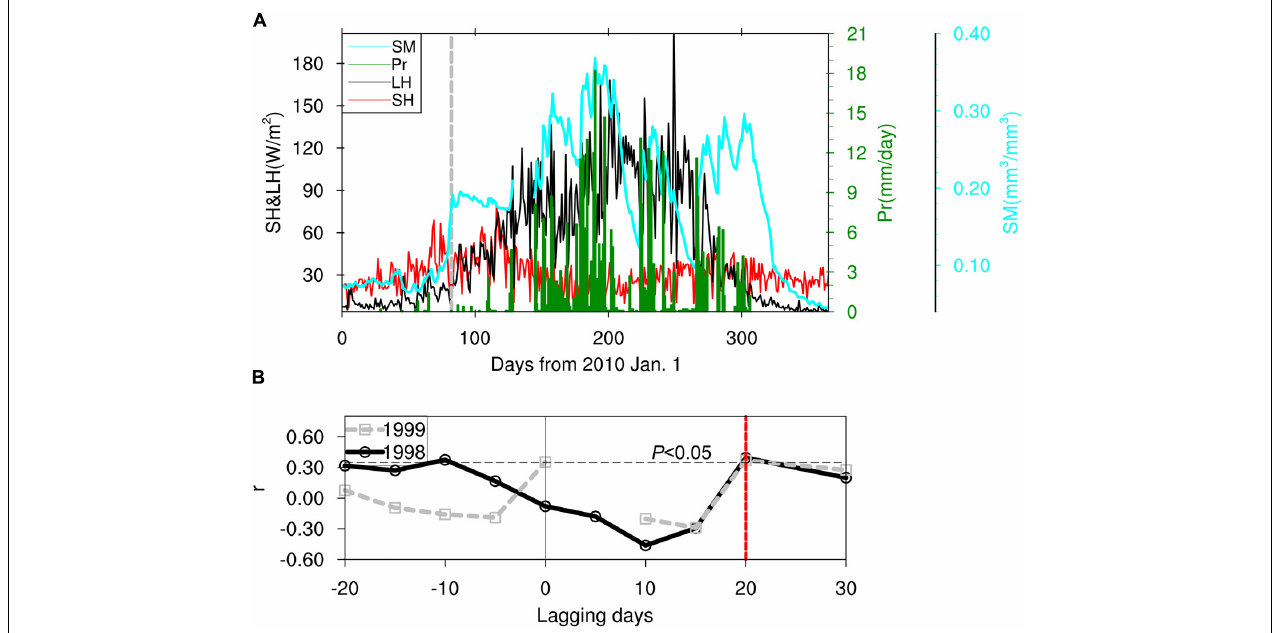
FIGURE 3 | (A) Evolution of the in situ observation of soil moisture (SM), precipitation (Pr), surface sensible heat (SH), and surface latent heat (LH) in Maqu; the gray dashed line indicates the date of soil complete thaw (days = 82). (B) Lagging correlations ( r ) between soil moisture and precipitation in TTH during spring in year 1998 (black solid line) and 1999 (gray dash line); the red dashed line represents the lagging days (=20) by which r in both 1998 and 1999 passes the Student t significant test ( p < 0.05). This figure is based on the data in Wang and Shang (2007).